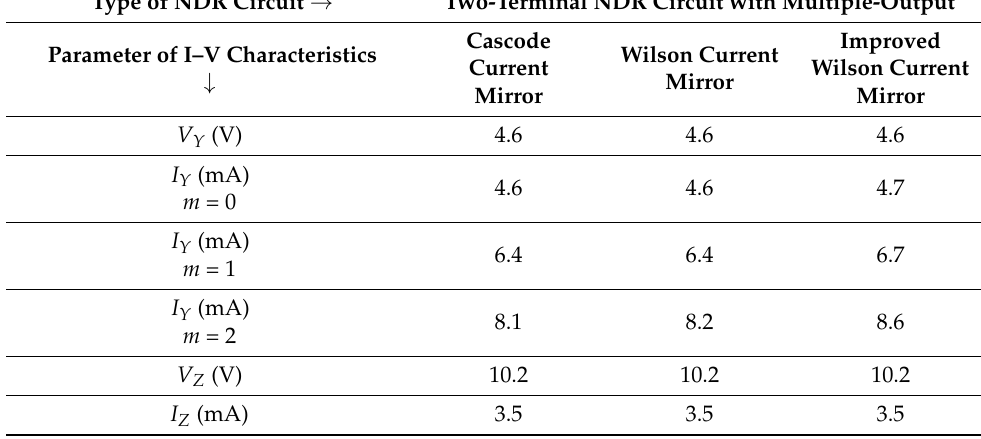
Figure 16. Calculated current-voltage characteristics of the NDR circuit with multiple-output improved Wilson current mirror in the NDR region; m = 0—green curve, m = 1—blue curve, m = 2—red curve. Table 2. Calculated parameters of current-voltage characteristics for different two-terminal NDR circuits ( T 0 —JFET).